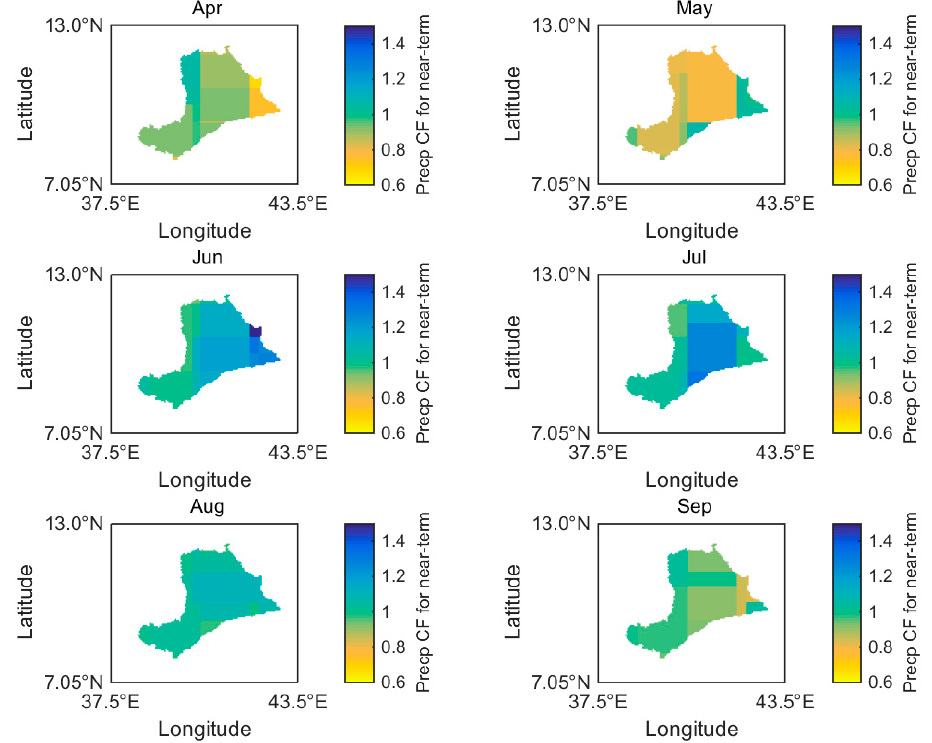
Figure 6. Precipitation change factors for April to September months for the near-term period, 2006–2030 (based on the median of the three models).